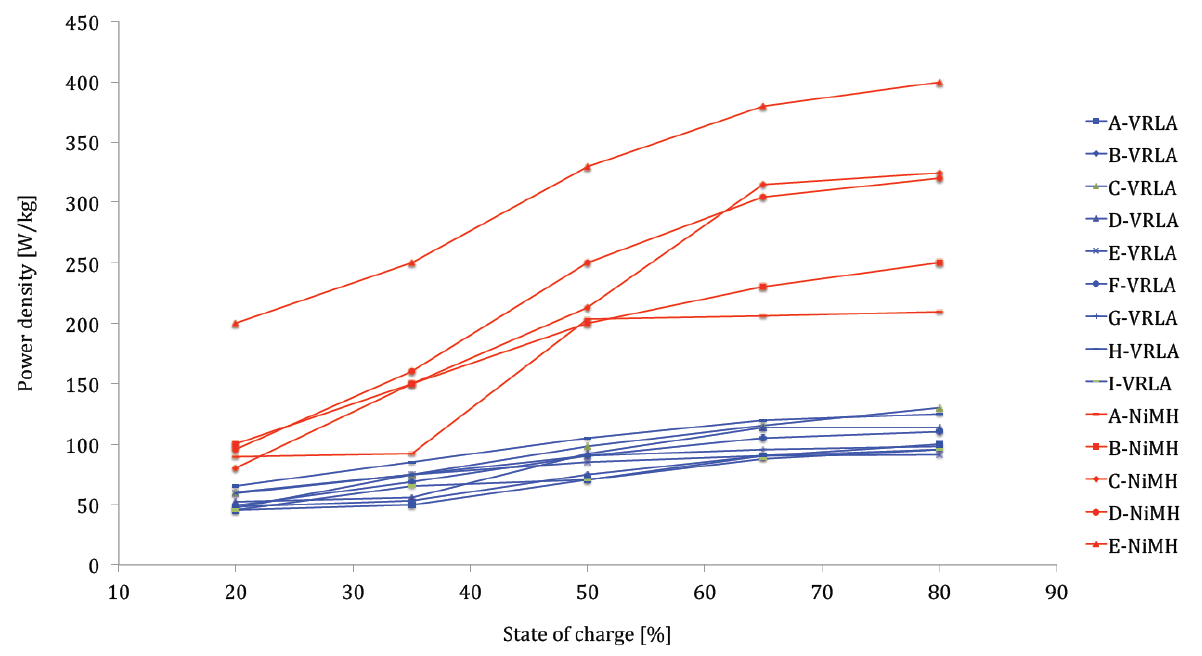
Figure 25. Power capabilities of nickel-metal hydride and lead-acid battery